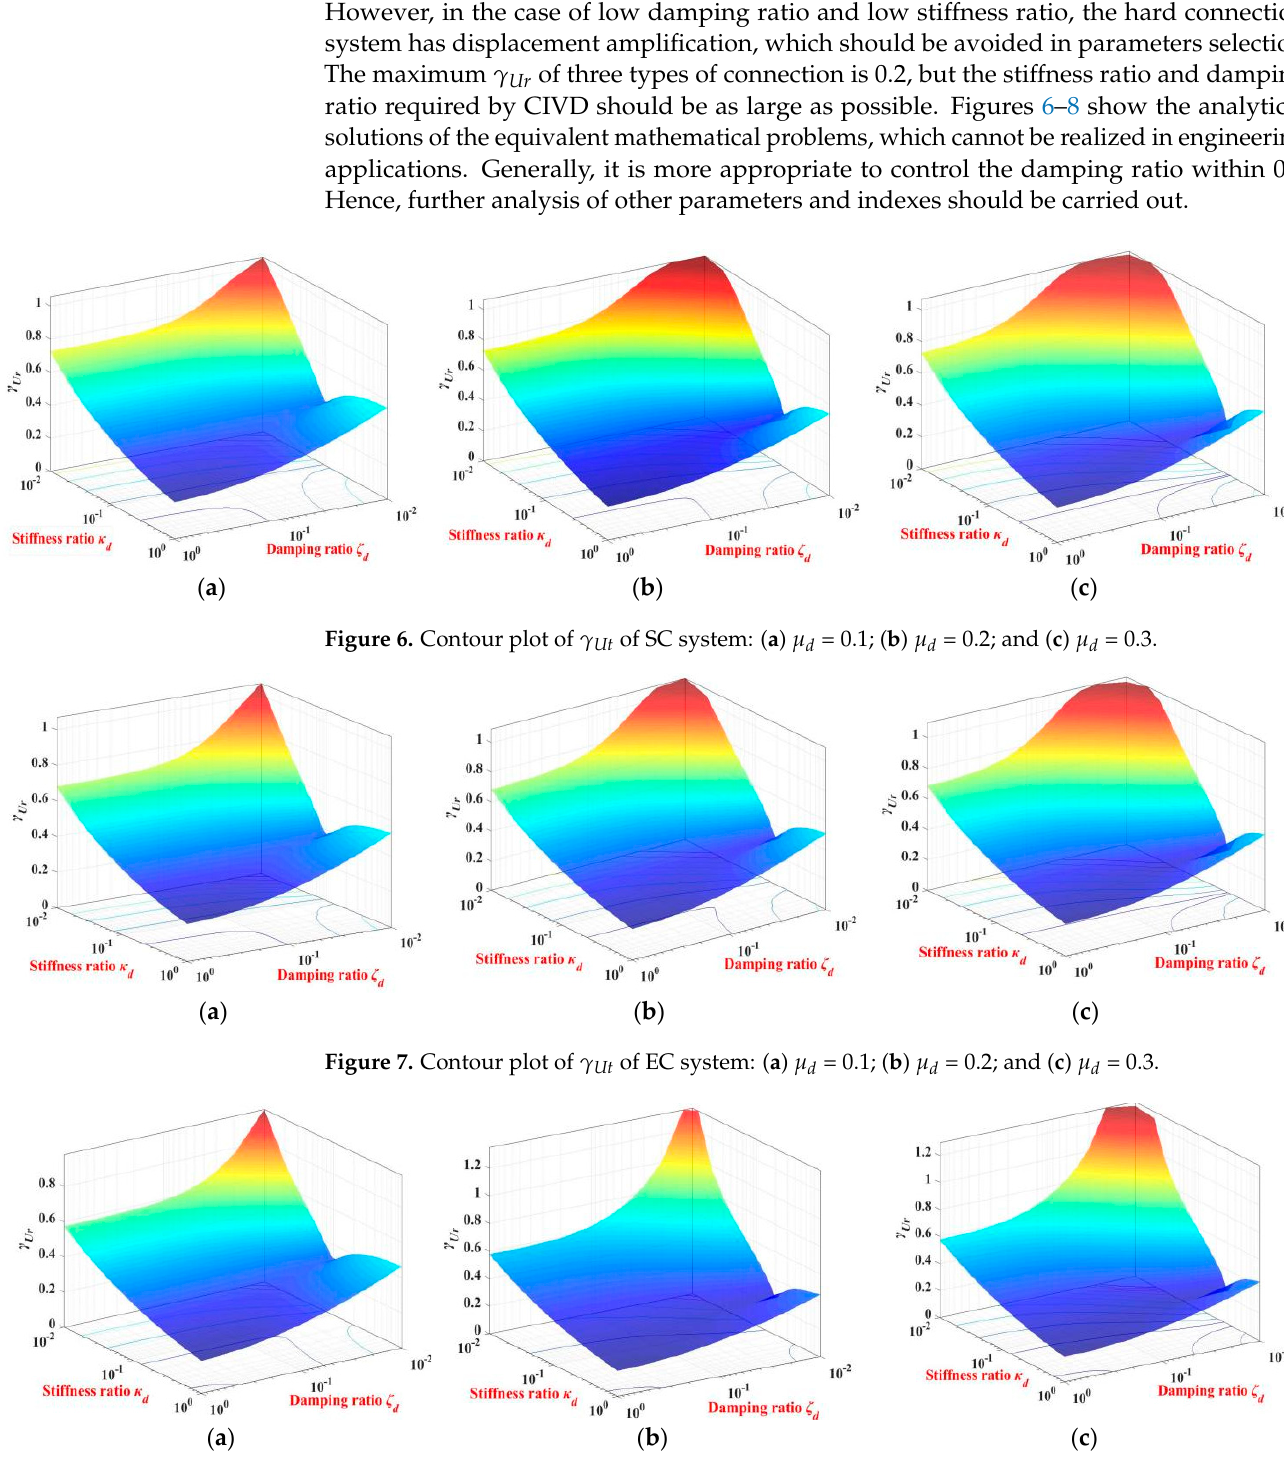
Figure 8. Contour plot of γ Ut of HC system: ( a ) μ d = 0.1; ( b ) μ d = 0.2; and ( c ) μ d = 0.3.